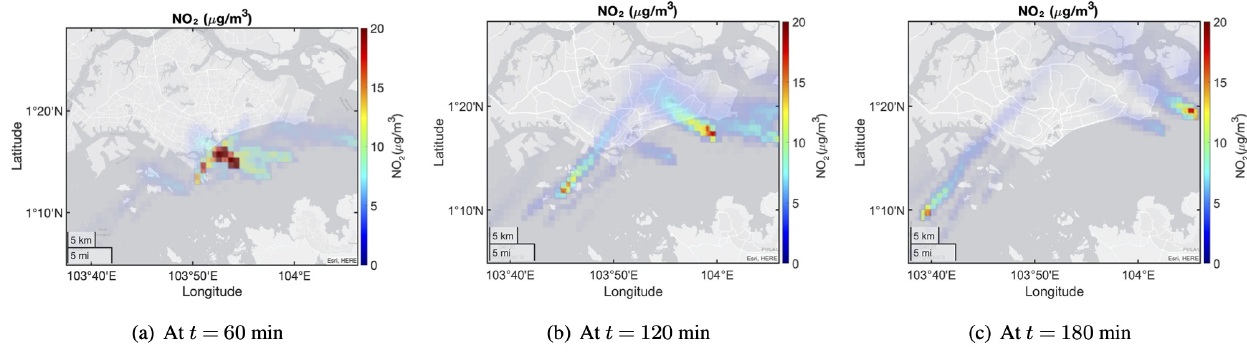
Figure 8. Instantaneous NO 2 concentrations near the ground by using the MPS model (case